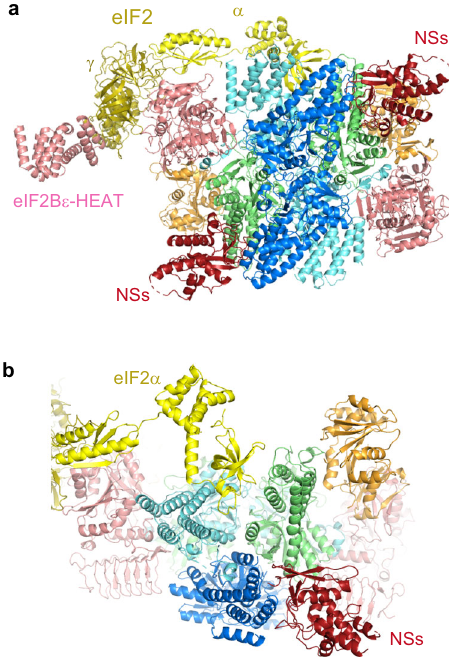
Fig. 3 Cryo-EM structure of the human eIF2B • SFSV NSs • unphosphorylated eIF2 complex. a Overall structure of the human eIF2B SFSV NSs unphosphorylated eIF2 (one eIF2-bound) complex. eIF2B and SFSV NSs are color-coded as in Fig. 1. The eIF2 α and eIF2 γ subunits are colored yellow and olive, respectively. b Close-up view of the interfaces for SFSV NSs and eIF2 α . These two molecules can bind eIF2B simultaneously and there is no direct interaction between